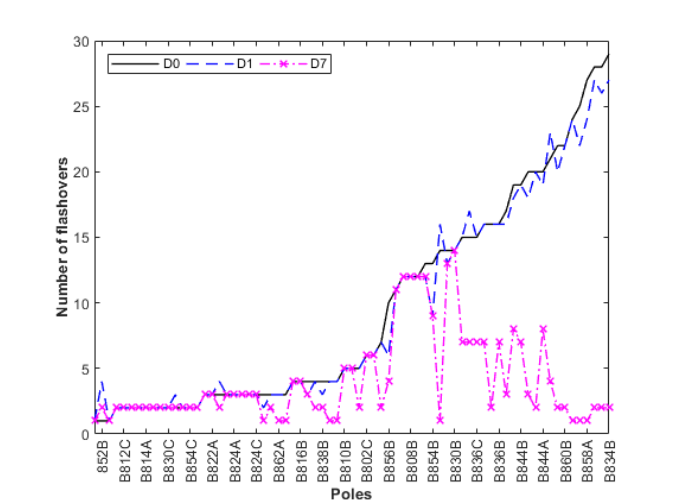
Figure 27. Comparing flashover occurrences for Case 3, with m = 0.5 and n = 0.5: base case (D0); lightning arresters at the transformer’s pole only (D1); lightning arresters at the transformer’s pole and at the six most critical poles (D7).